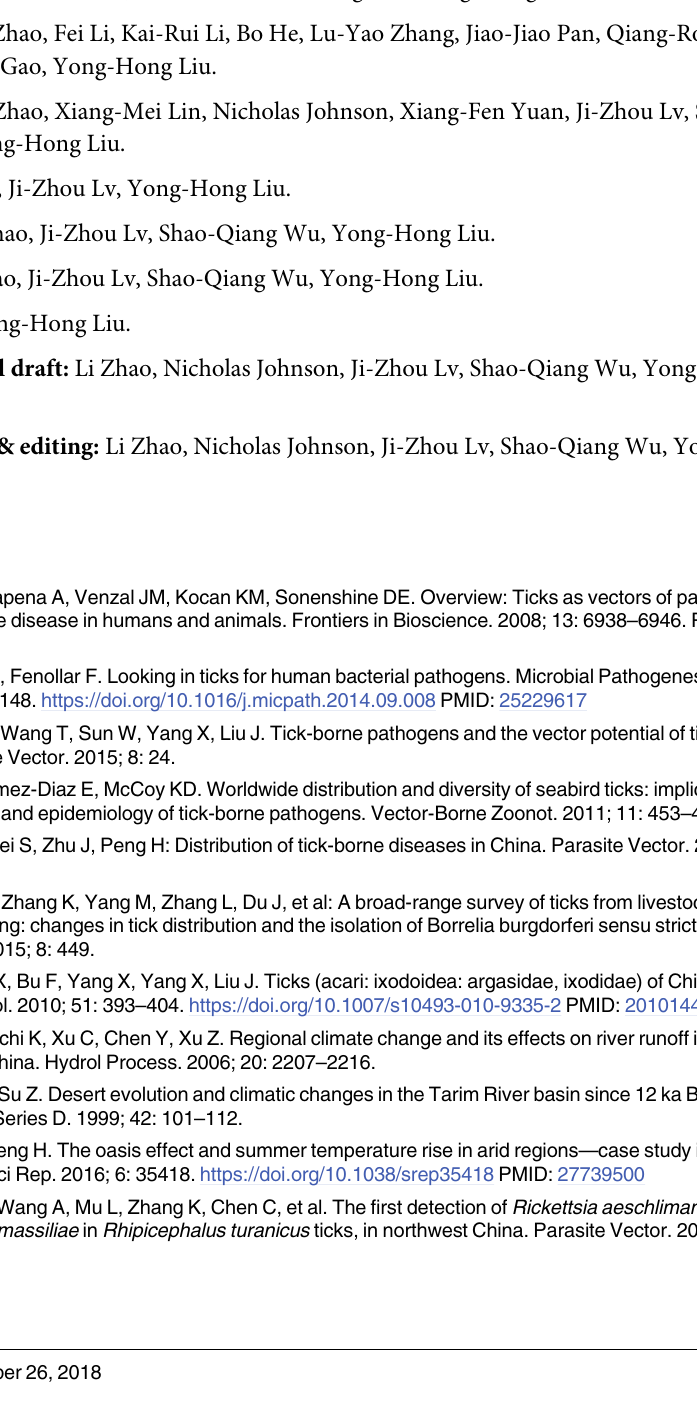
S2 Table. Genbank Accession numbers for sequences of ticks and tick-borne